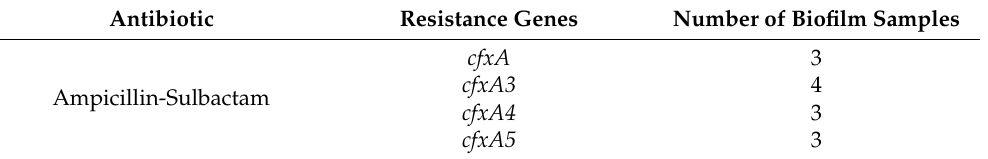
Table 5. Prevalence of ARGs in the